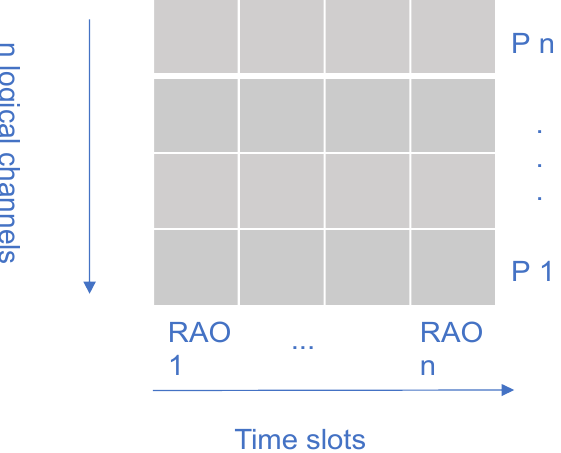
Figure 1. The frame structure of RA typically employed in mobile networks. Preambles ( P 1 up to P n ) are rotated in every RAO.